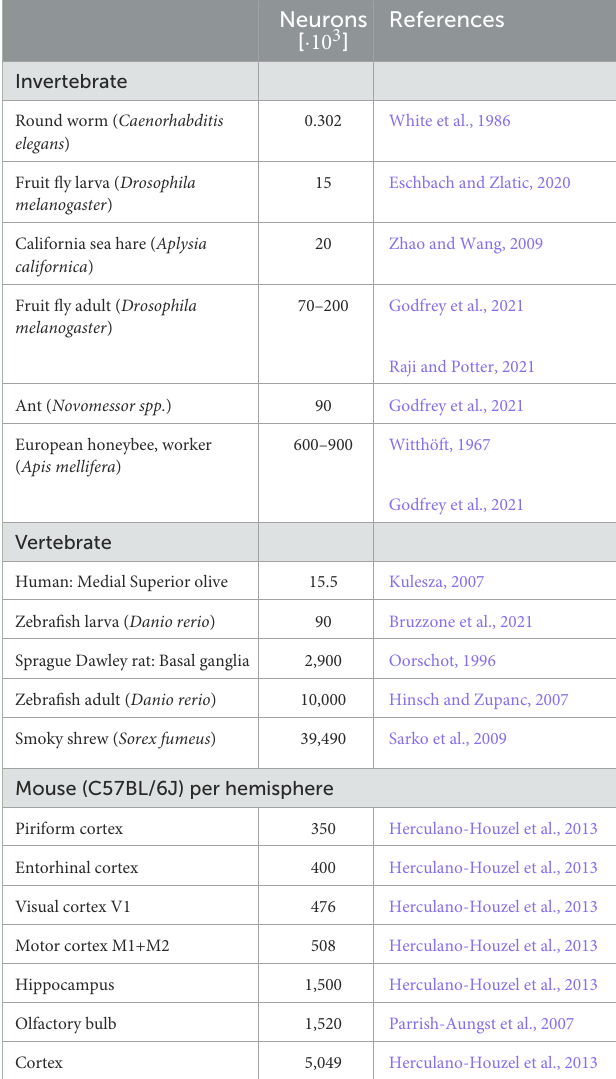
TABLE 5 Number of neurons of selected model organisms and